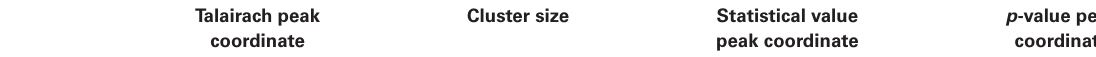
Table 1 | Statistical details of activation foci obtained by group fMRI analysis. Brain region Talairach peak Cluster size Statistical value p -value peak coordinate peak coordinate